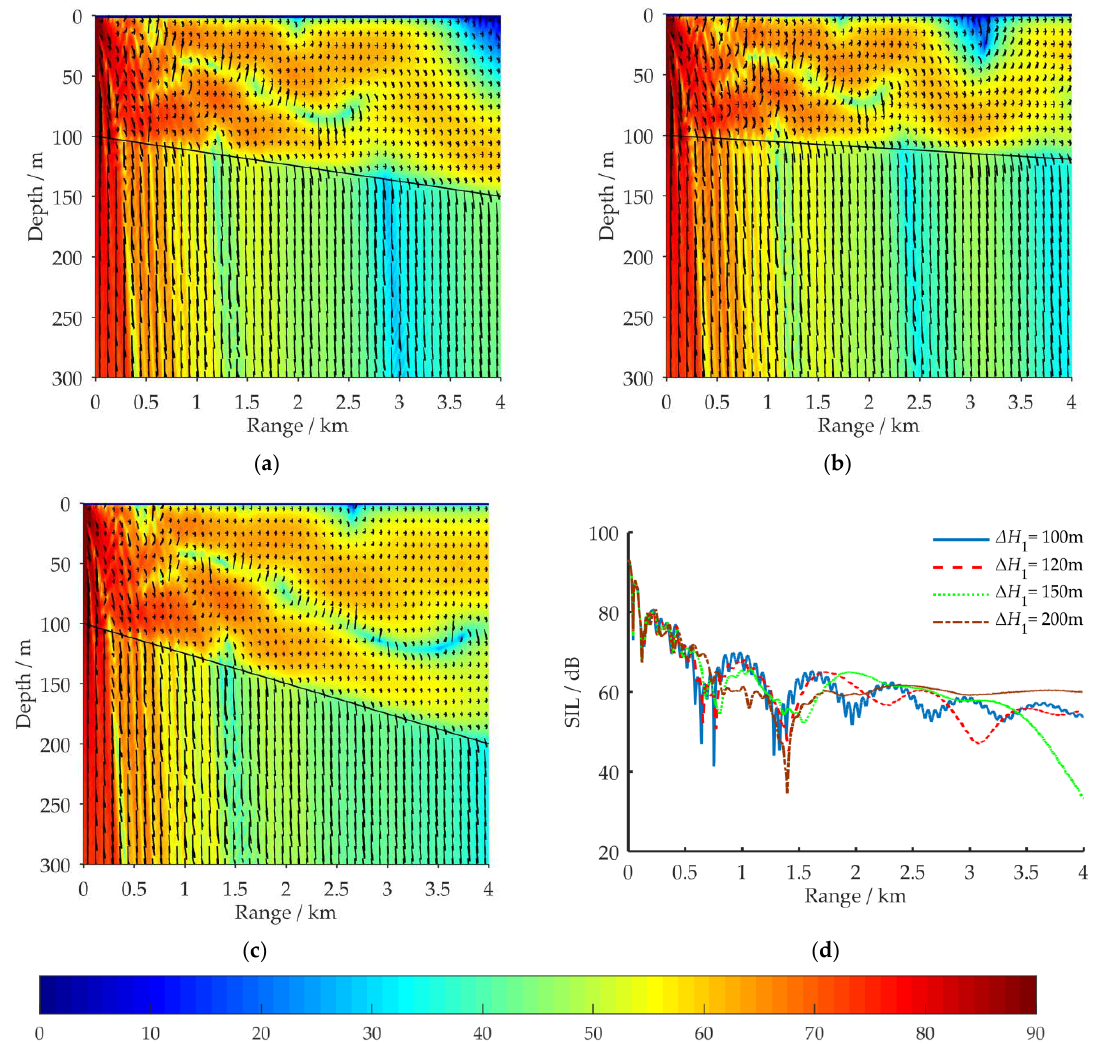
Figure 7. Distribution of the 100 Hz acoustic energy flux (SIL) in a full waveguide of shallow water with wedge-shaped downhill sea bottoms; aside from △ H 1 , the environmental parameters are the same as in Figure 2a: ( a ) △ H 1 = 120 m; ( b ) △ H 1 = 150 m; ( c ) △ H 1 = 200 m; ( d ) comparison results of SIL curves for four simulation conditions: △ H 1 = 100, 120, 150, and 200 m, with a receiving depth of z = 50 m.